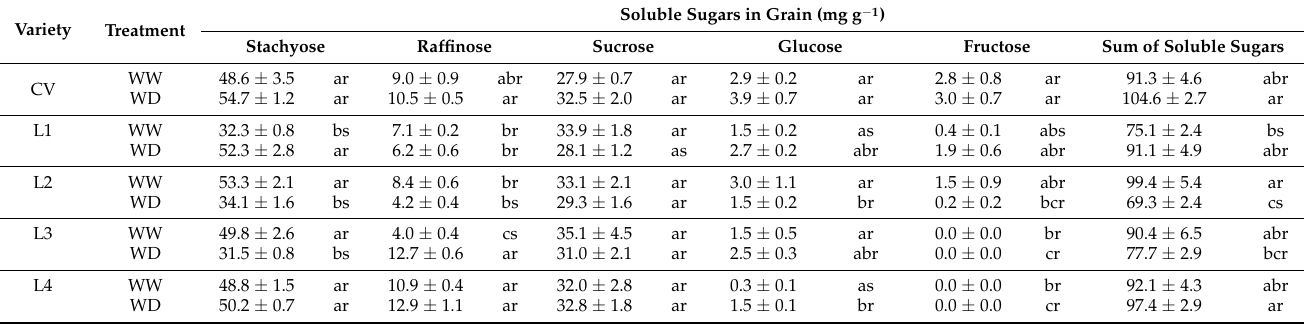
Table 5. Soluble sugar contents (mg g − 1 ) in cowpea grain in well-watered (WW) and water deficit (WD)